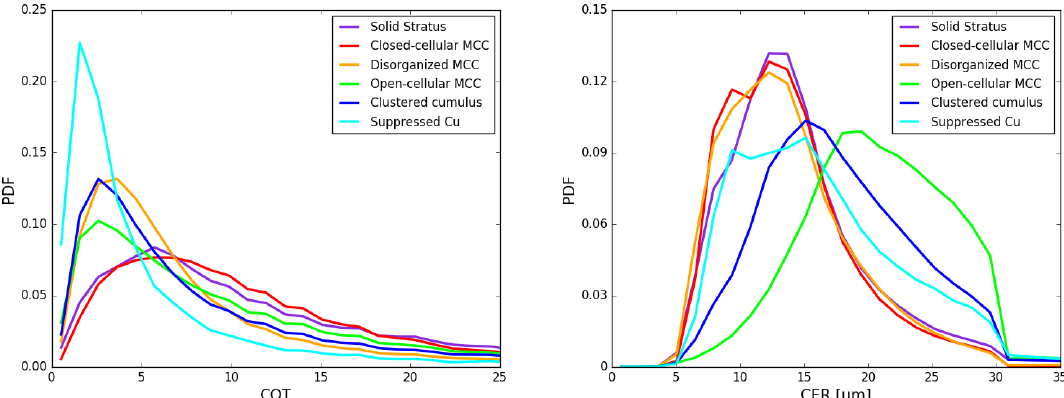
Figure 4. PDFs of cloud optical depth and cloud effective radius for six morphology types. We randomly selected 1000 samples for each type, and mean distributions are shown here. Significant overlaps are observed for PDFs of both variables among different morphology types.